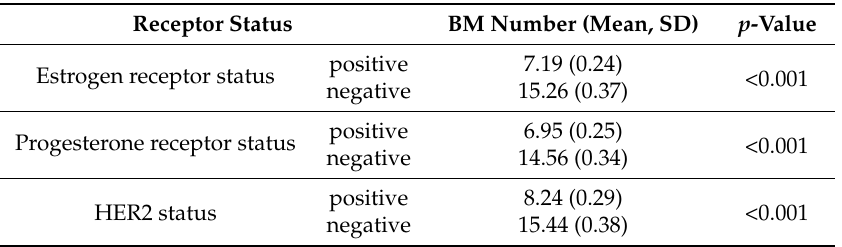
Table 2. Number of the brain metastases depending on BC